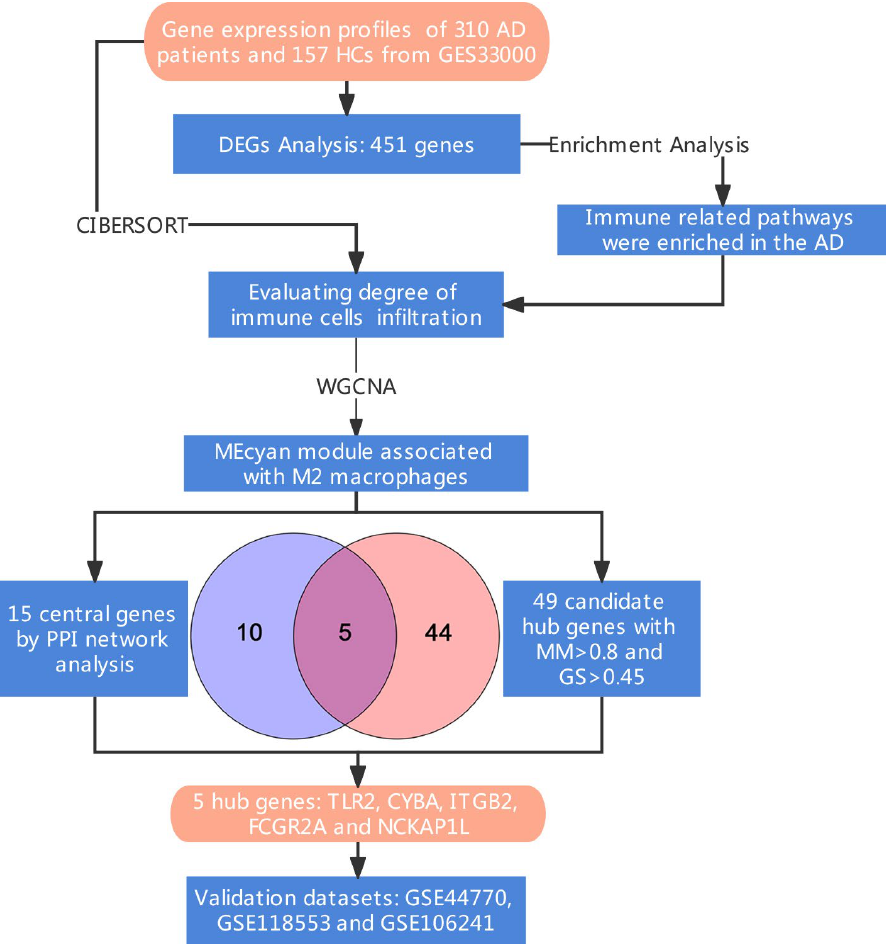
Figure 1. Research design flow chart.